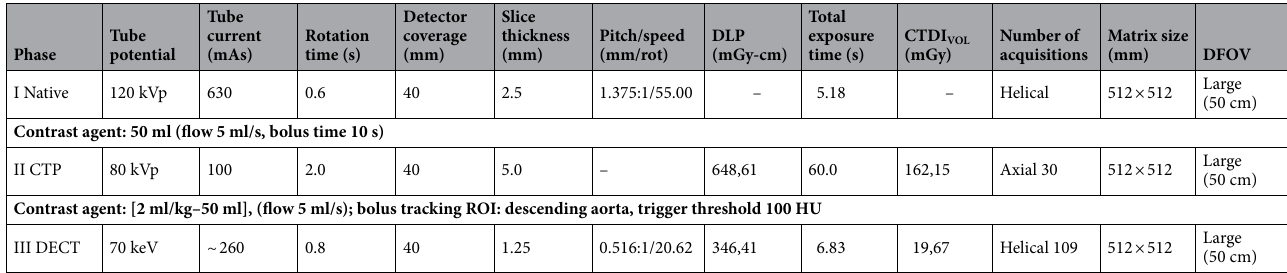
Table 1. Acquisition protocol for dynamic CTP and DECT. DECT dual-energy computed tomography, CTP perfusion computed tomography, CTDI vol volume dose index, DFOV display field of view.